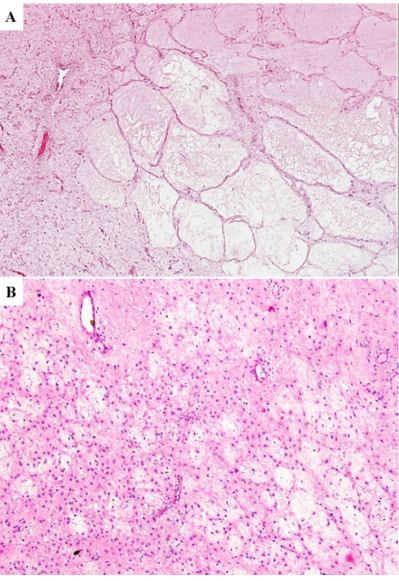
Figure 7. Cystic stromal changes in primary DAM . Abundant edematous stromal changes impart- ing a macrocystic ( A ) and microcystic ( B ) appearance to the tumor.